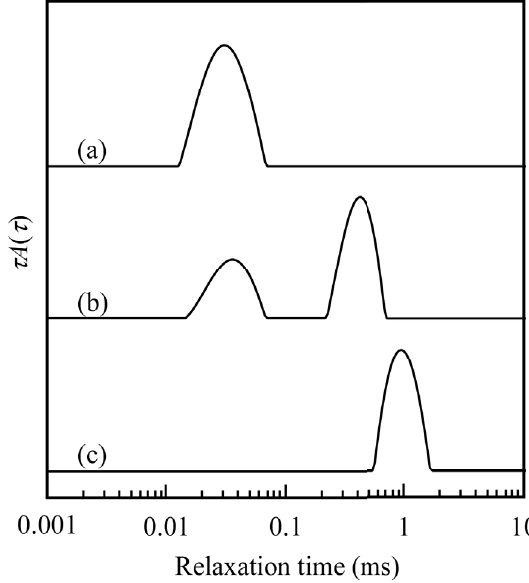
Figure 7. Typical examples of DLS relaxation time distributions for PMPC = 5.0 g/L in 0.1 M NaCl at 25 °C ( a ), 42 °C ( b ), and 60 °C ( c C p